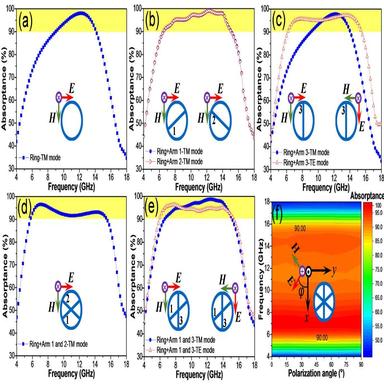
The absorption spectra of WMAs with different parts of "wheel-like" pattern as element under normal incident plane wave. (a), (b) and (d) are results under TM waves while (c) and (e) are results under both TE and TM waves. (f) 3D plot of microwave absorptance of proposed WMA changing with frequency and polarization angle.